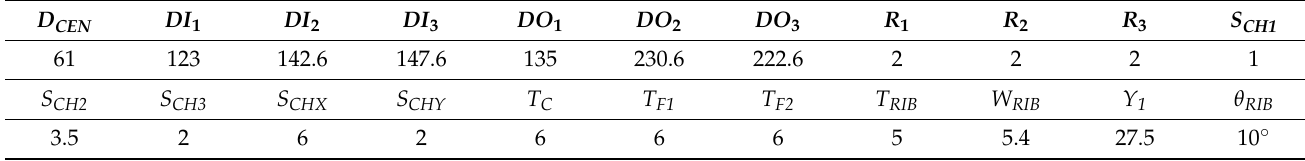
Table 1. Initial values of the 22 geometrical parameters for the baseline model §